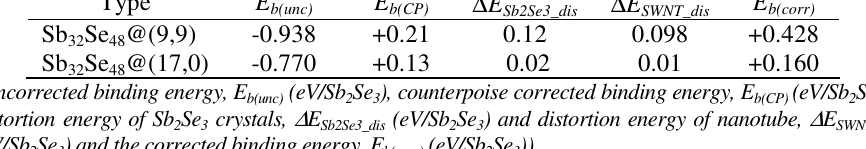
Table 6. The binding energy for Sb